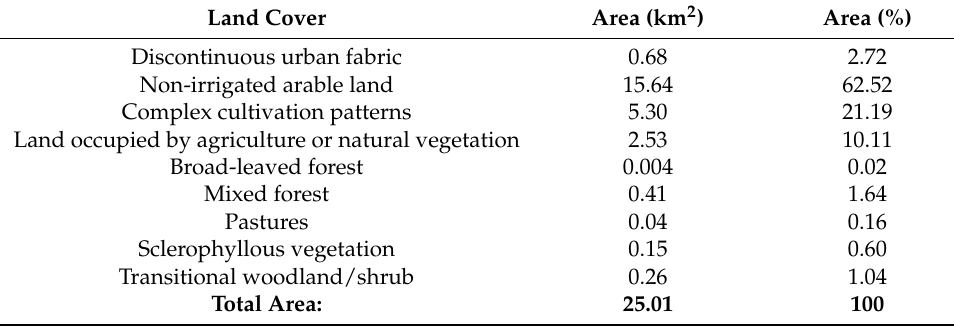
Table 12. Inundated area per land cover for the overtopping